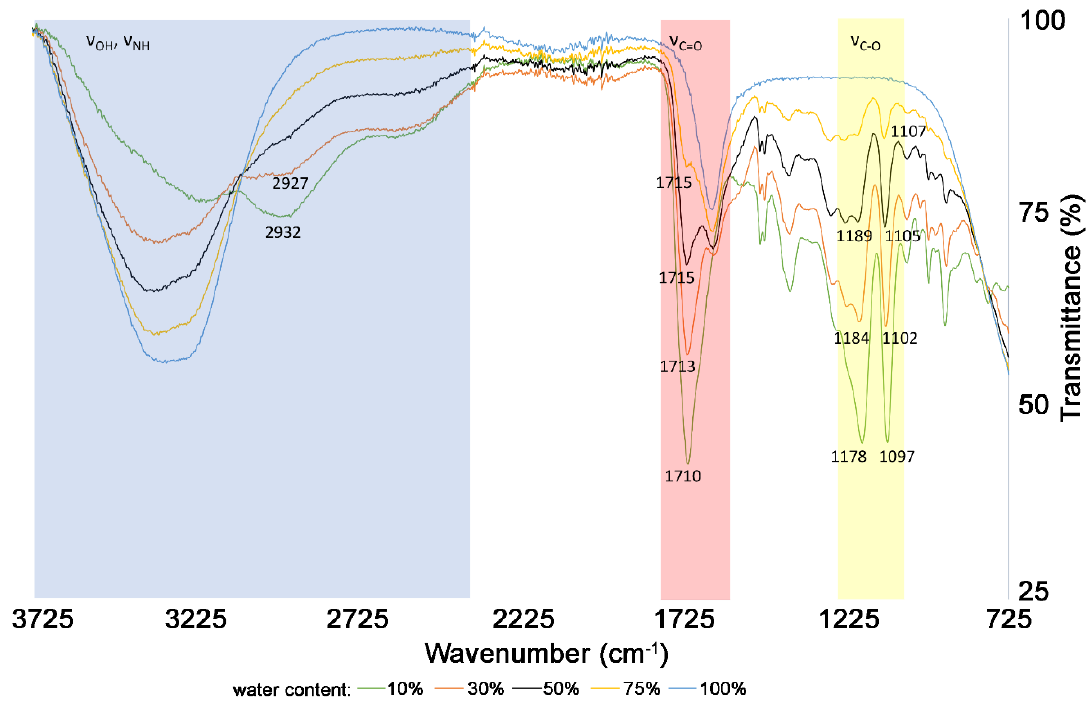
Figure 3. The e ff ect of water content on the supramolecular structure of DES-3 based on FT-IR Figure 3. The effect of water content on the supramolecular structure of DES-3 based on FT-IR spectra.